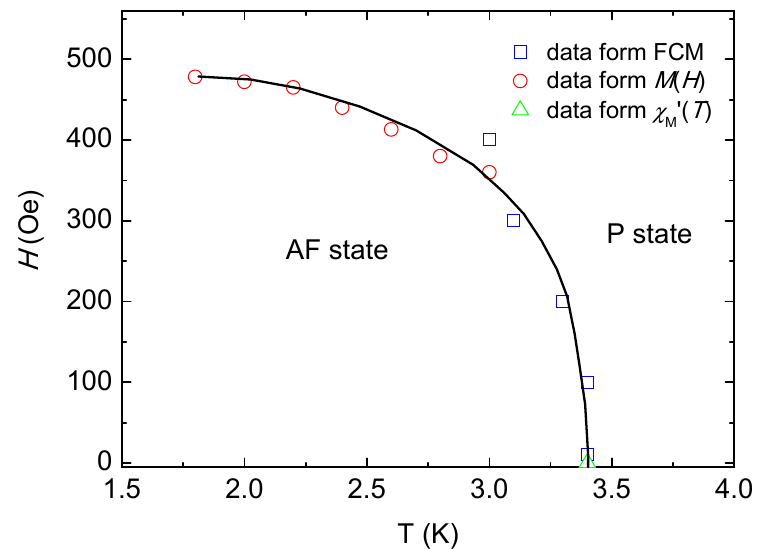
Figure 6. Magnetic phase (T, H ) diagram for 1 , build up using the location of the maximum of χ M vs. T data (open blue square), location of the maximum from dM/dH vs. H data (open red circle) and AC data (open green triangle); the solid line is a guide.